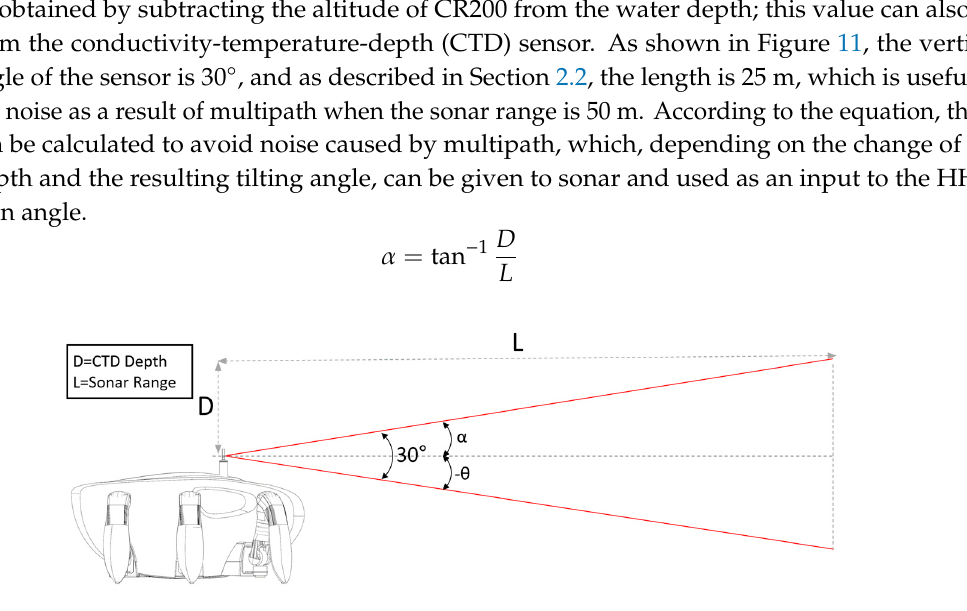
Figure 11. Hula hoop motion (HHM) inclination angle of the scanning sonar.